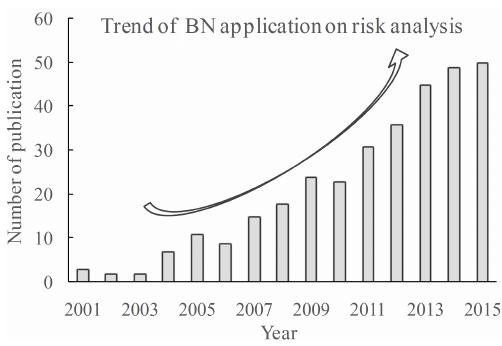
Figure 1. Increasing application of BN in risk analysis (update of Weber et al., 2012).